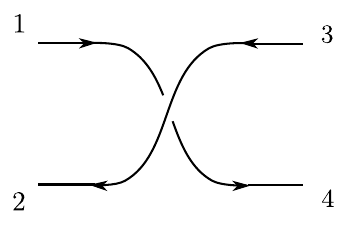
Figure 4 . Zero-rung four-point